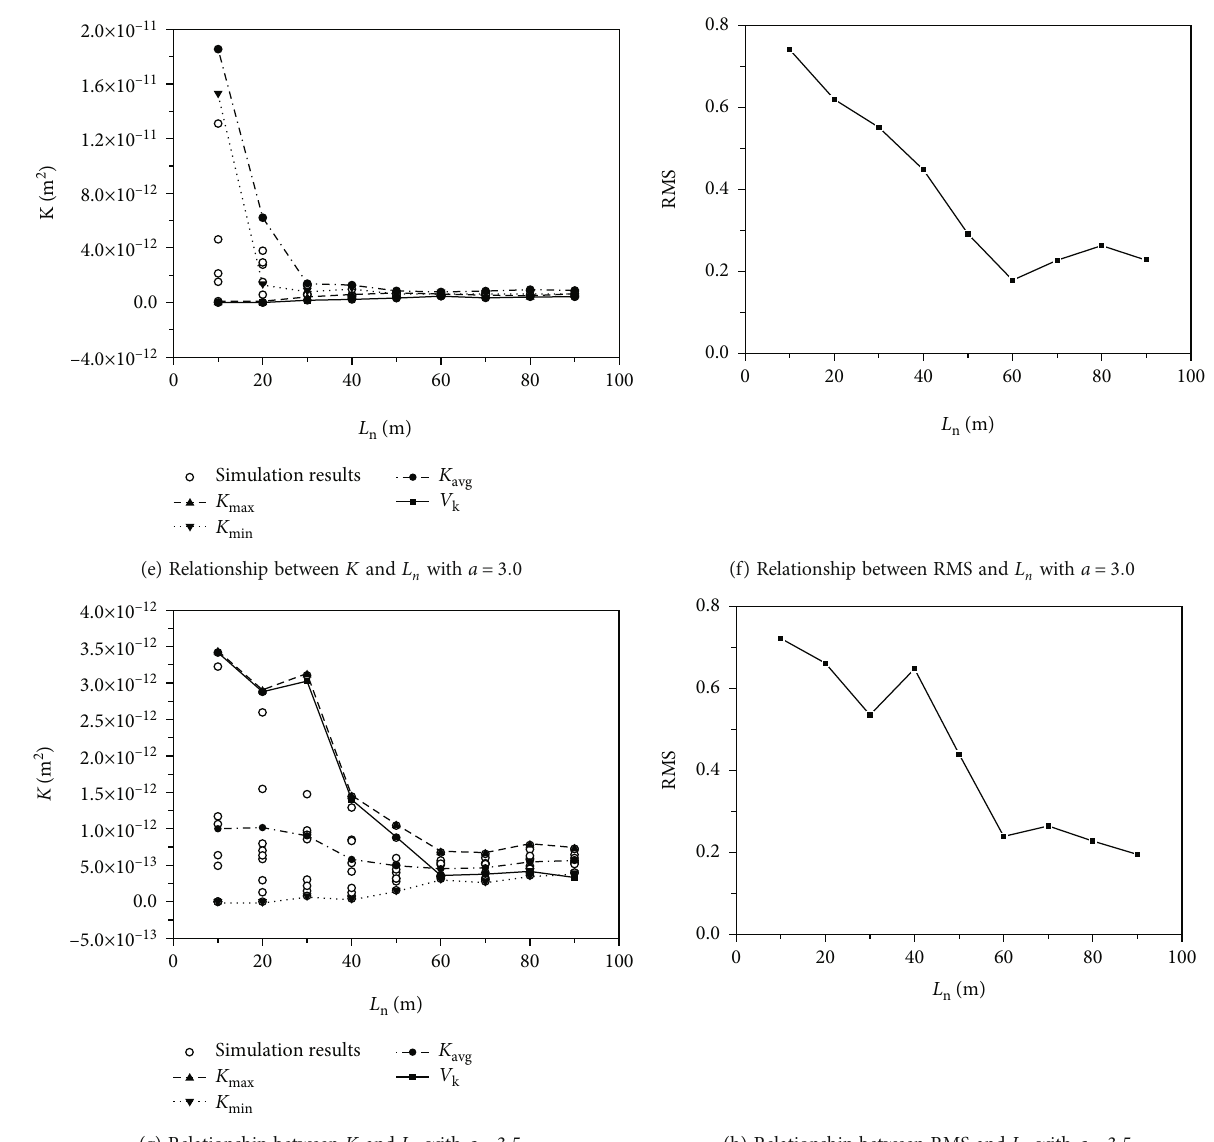
(h) Relationship between RMS and L n with a = 3 : 5 Figure 11: